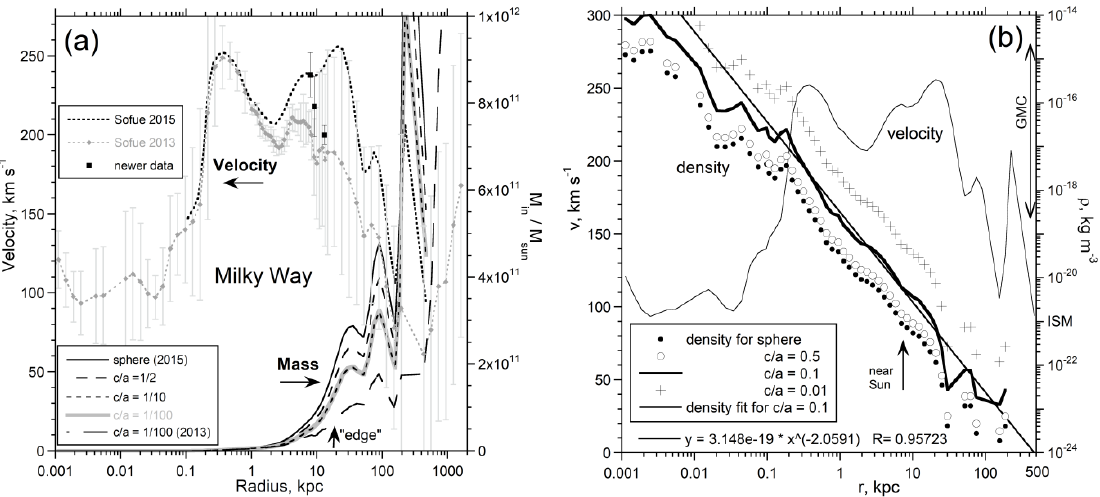
Figure 3. Inverse models showing the effect of varying c / a over a large range for an internally probed galaxy, the Milky Way. Compiled RCs are used to calculate ( a ) mass inside and ( b ) density at any given radius. In part ( a ), upper box describes line patterns associated with RCs [58,59,66] using the left axis and two additional constraints on v near the Sun [81,82] and from globular cluster data [60]. Lower box lists aspect ratios assumed in analyzing each dataset for mass, shown on the right axis. Error bars on v from [58] are shown. Downturns in M in and ρ indicate that the “edge” of the Galaxy is gradual and between 18 and 30 kpc. In ( b ), density above r = 0.1 kpc was fit to a power law, as shown.